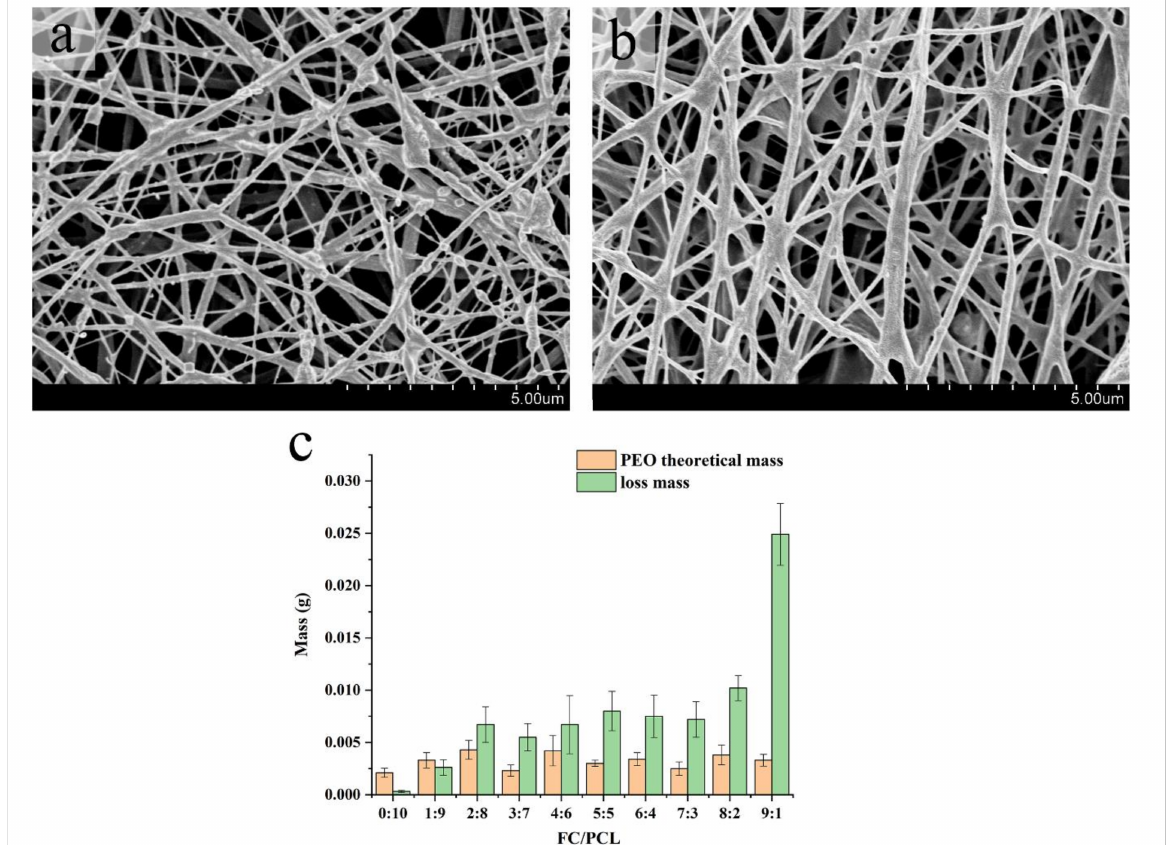
Figure 3. Results of PEO removal. ( a ) SEM image before PEO removal, ( b ) SEM image after PEO removal, ( c ) Mass loss of PEO